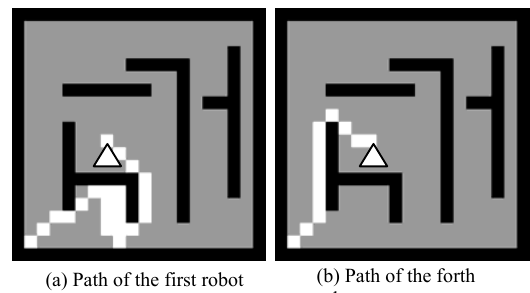
Fig. 15 Modified planning algorithm is applied to a sequence of robots in an environment with convex and concave obstacles. ( ∆ shows goal points)